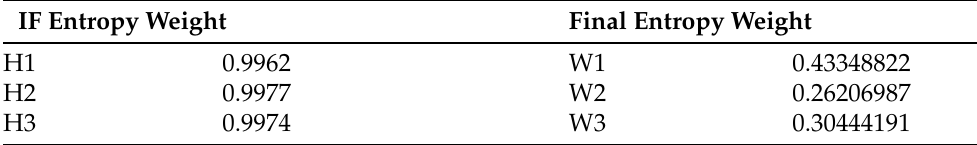
Table A3. IF entropy weights and final entropy weight for environmental sub-barriers.